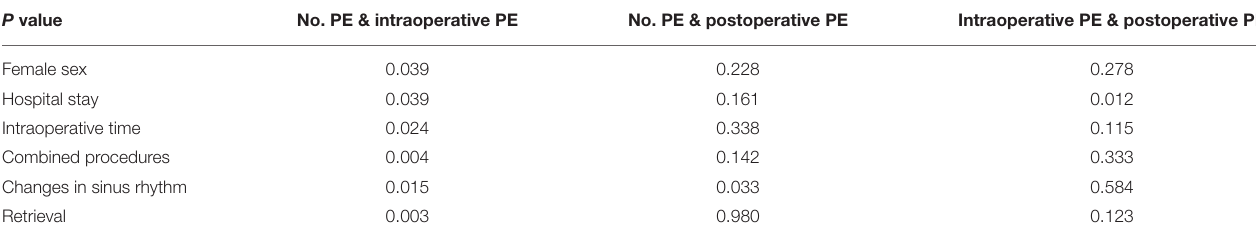
TABLE 4 | The predictors for pericardial effusion (comparison within